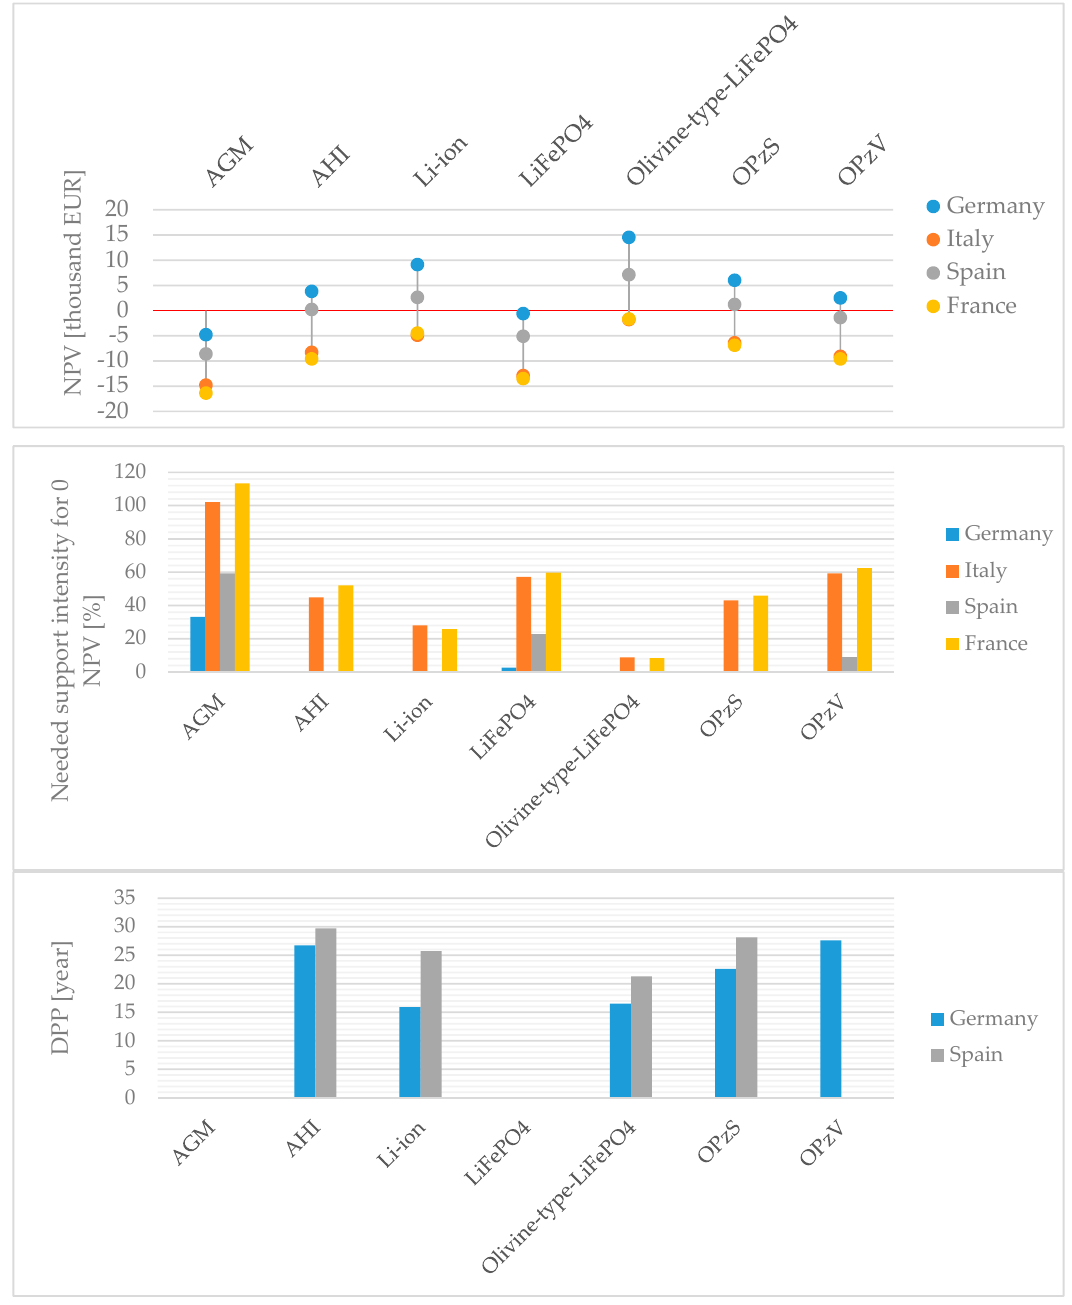
Figure 7. Net present values, needed support for 0 present value (NPV) in percentage of the total investment cost and discounted payback periods (DPP) by battery type in the studied countries within a 30-year period.